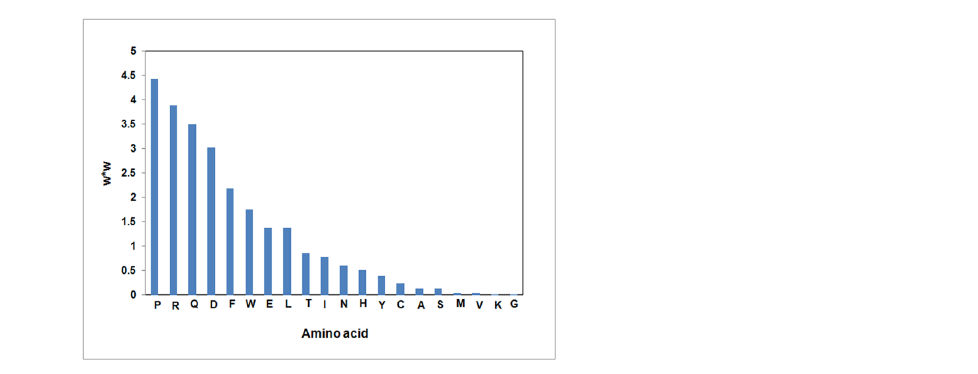
Fig 1. Feature ranking of the EAPcompo model. X-axis is the type of amino acid, Y-axis is W * W .